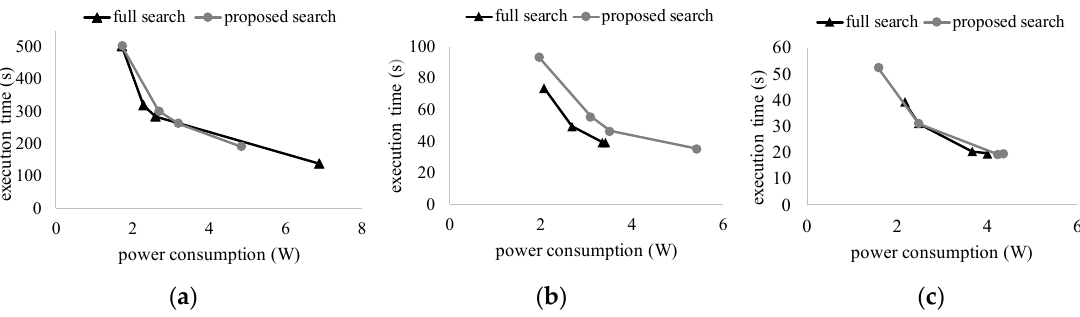
Figure 3. Comparison of NMP offloading decision between the proposed eight-search and the full 16-search ( a ) PARSEC, ( b ) SPLASH-2, and ( c ) VGG-F.